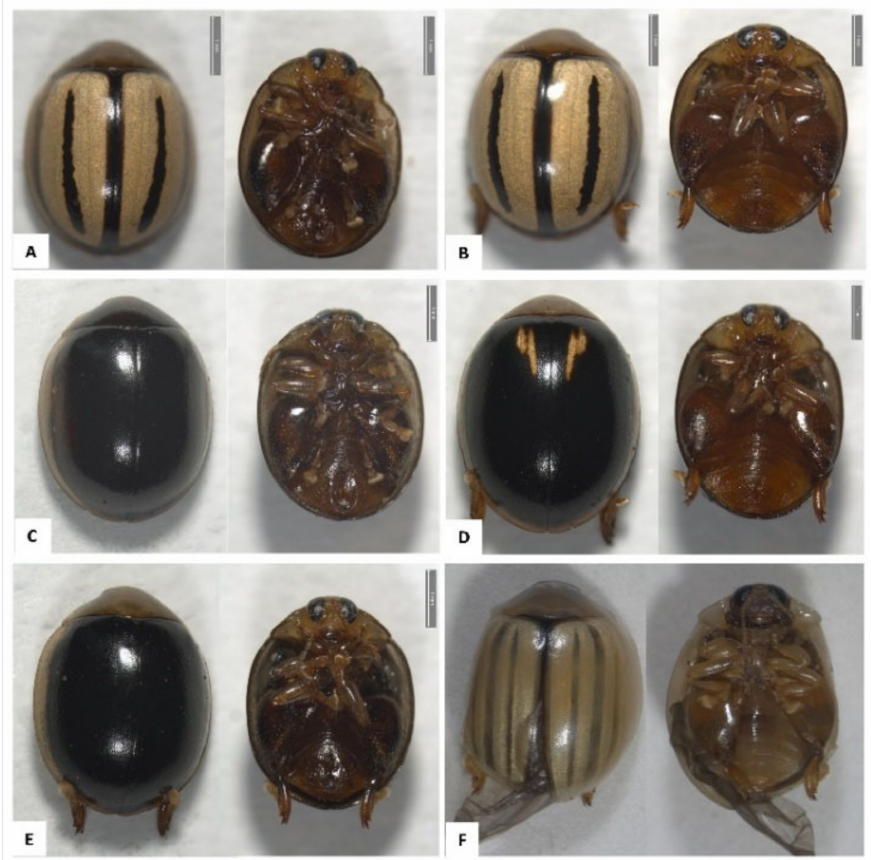
Figure 1. Representative adult specimens of olive flea beetles (Chrysomelidae: Alticini) species found in the Western Cape of South Africa. ( A ) Argopistes sexvittatus , black morphotype (male); ( B ) A. sexvittatus , black morphotype (female); ( C ) A. sexvittatus , black morphotype (male); ( D ) A. sexvittatus , striped morphotype (male); ( E ) A. sexvittatus , striped morphotype (female); ( F ) Argopistes capensis (female). Image credits: Elizabeth